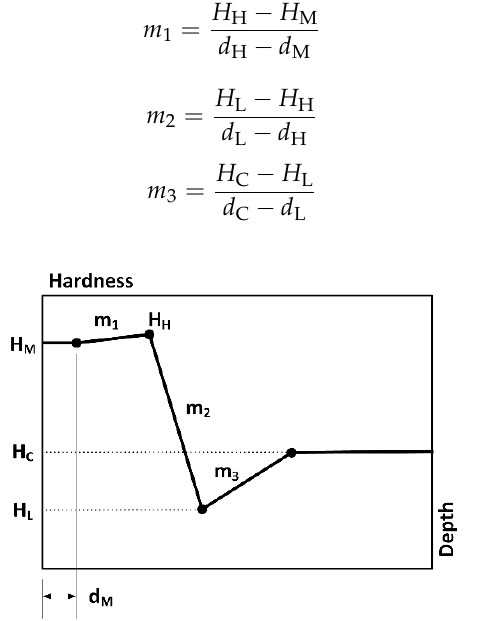
Figure 6. Geometrical technique for extracting attributes.